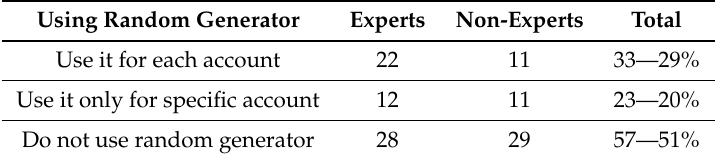
Table 24. Sixty-two Experts and 51 Non-experts (113 users) who use a random password